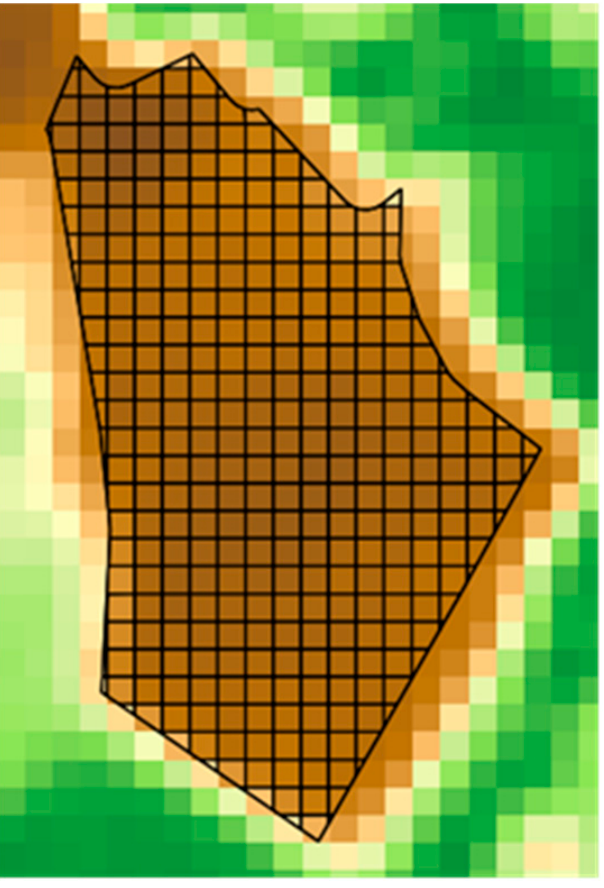
Figure 4. Extraction of pixel values contributing to the median satellite-derived biophysical varia- bles at the field scale. Example of DMC-derived fAPAR after inward